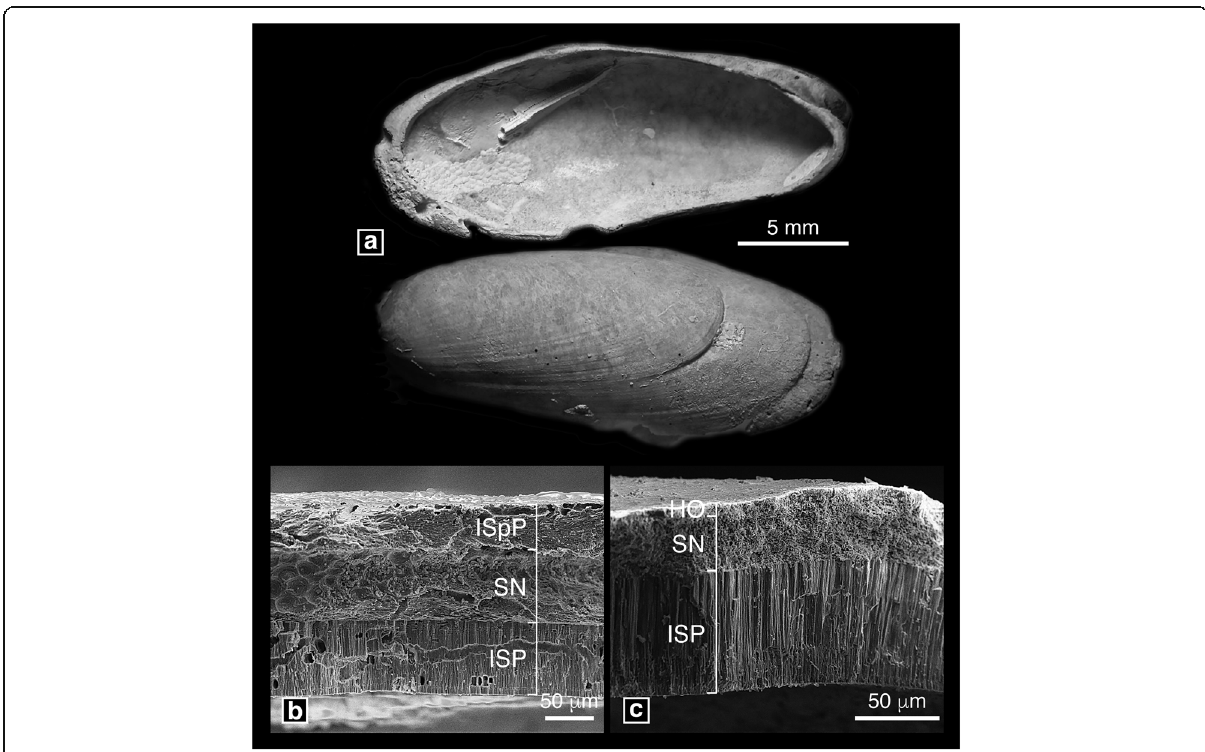
Fig. 9 Boring mytilid bivalves from deep-water macroids off Kikai-jima, Japan. a Leiosolenus sp., inner and outer shell surface. b , c SEM photos illustrating shell microstructures of Lithophaga sp. ( b ) and Leiosolenus sp. ( c ). HO, homogeneous structure; SN, sheet nacreous; ISP, irregular simple prisms; ISpP, irregular spherulitic prisms